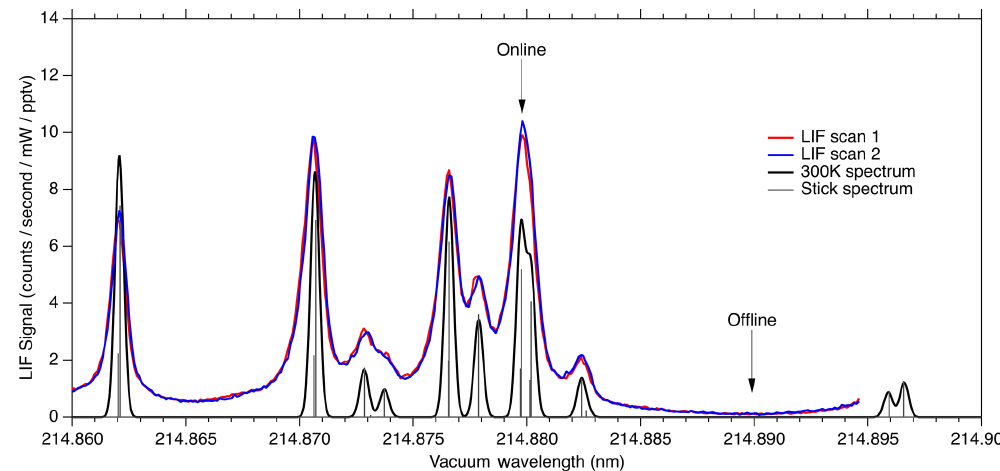
Figure 8. LIF signal observed during laser scans compared to calculated absorption cross section at